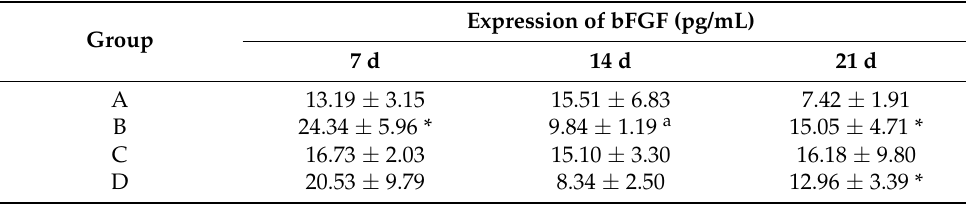
Figure 5. Expression results of EGF at different time points. Notes: (A): model group; (B): dracorhodin perchlorate inflammation targeting emulsion gel group; (C): dracorhodin perchlorate non-targeting emulsion gel group; (D): positive group. Scale bar is 50 µ m. Table 2. Expression of bFGF in the granulation tissue of rats at the different stages (x ± s). Group